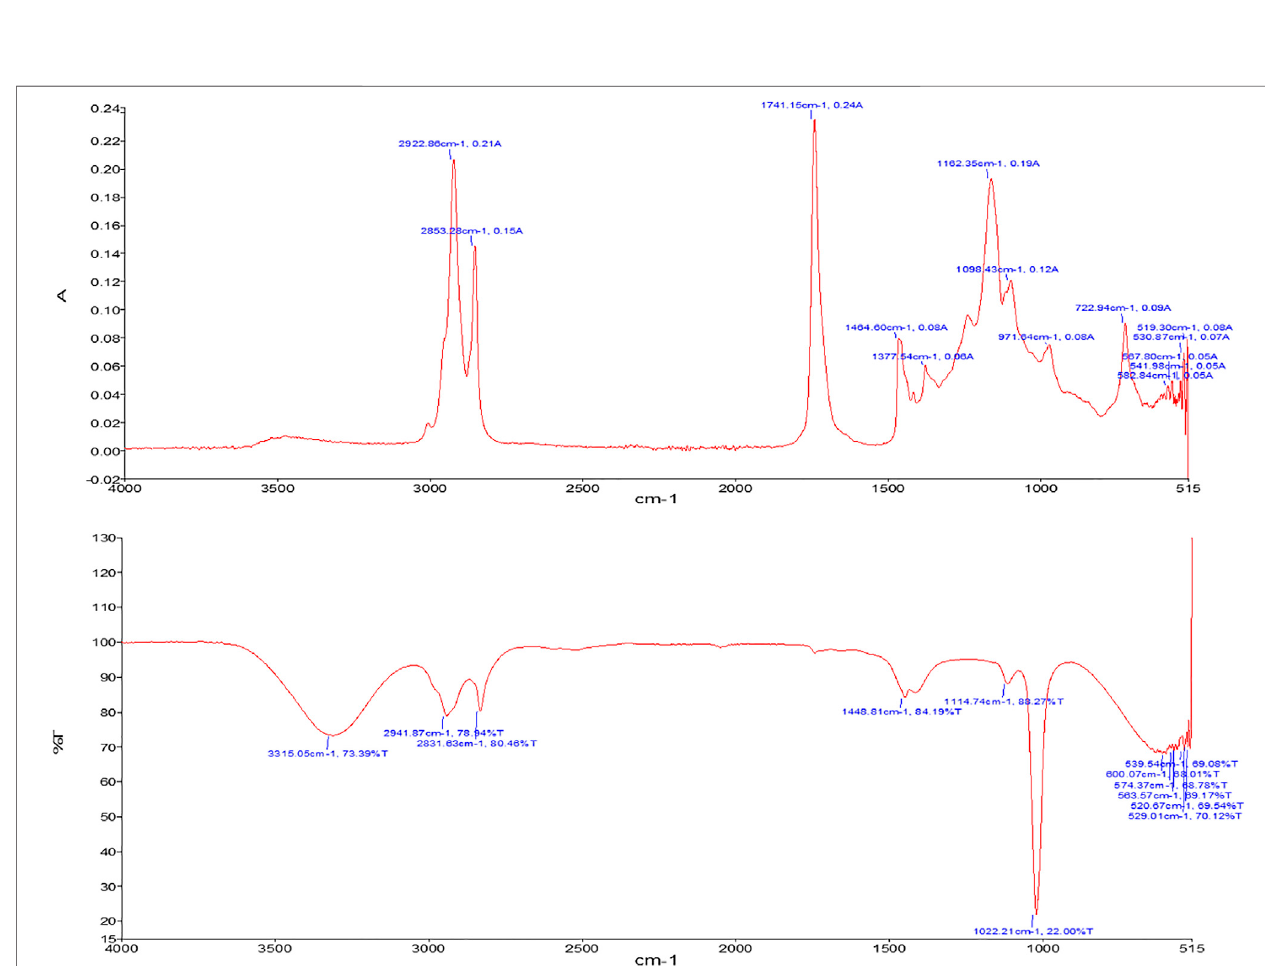
FIGURE 6 | FT-IR spectrum of Cucumis melo var. agrestis oil (upper), biodiesel (lower).